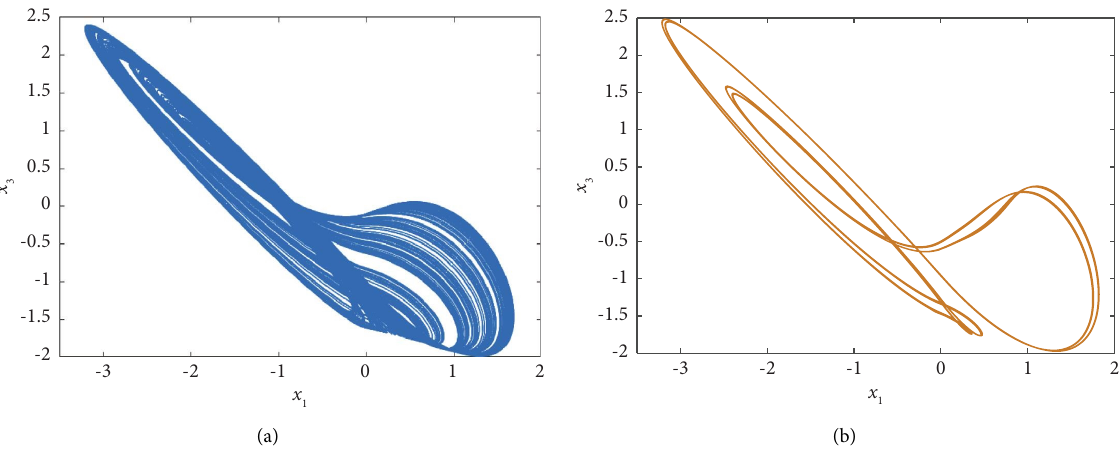
Figure 14: Phase diagrams of the system. (a) Phase diagram of x x − x plane system in t ∈ ( 4000s − 5000s ) interval. 1 3